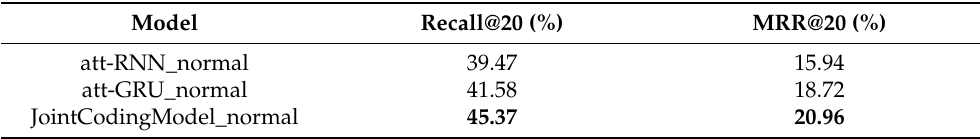
Table 2. Experimental results of the normal